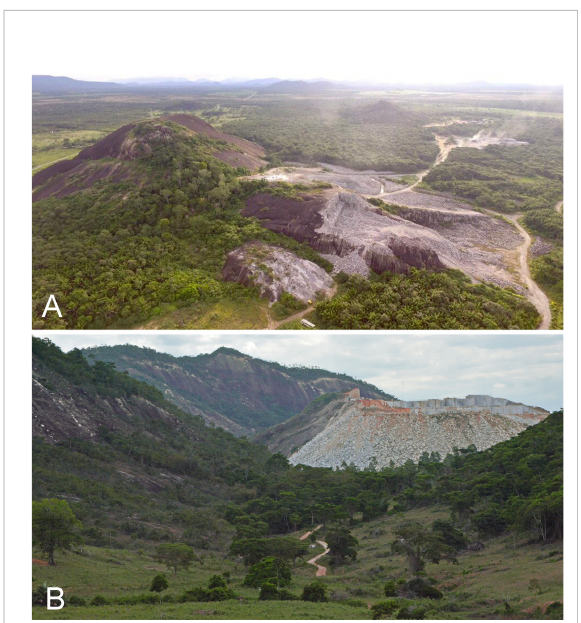
FIGURE 7 Intense threats to South America's inselbergs. (A) Aerial view of mining in Mucaja ı ́ municipality, Roraima state (Amazonian biome). (B) Mining practices threatening inselbergs on the